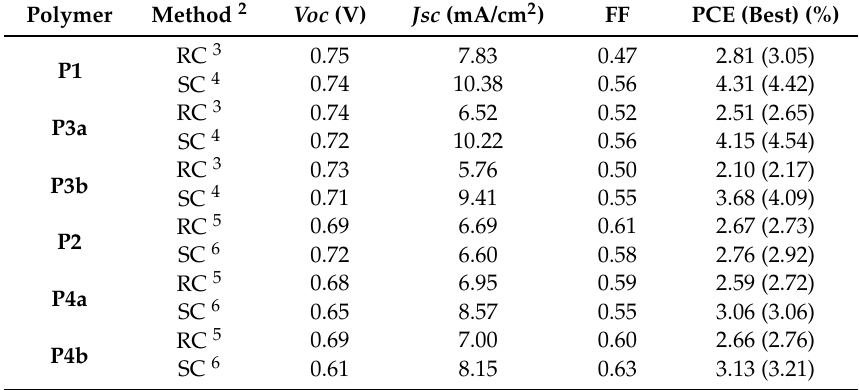
Table 2. Current-voltage ( IV) parameters 1 ( Voc , Jsc , fill factor (FF) and power conversion efficiency (PCE)) for the polymer:phenyl-C 61 -butyric acid methyl ester (PC 61 BM) RC and SC solar cells based on P1 , P2 , P3a , P3b , P4a and P4b